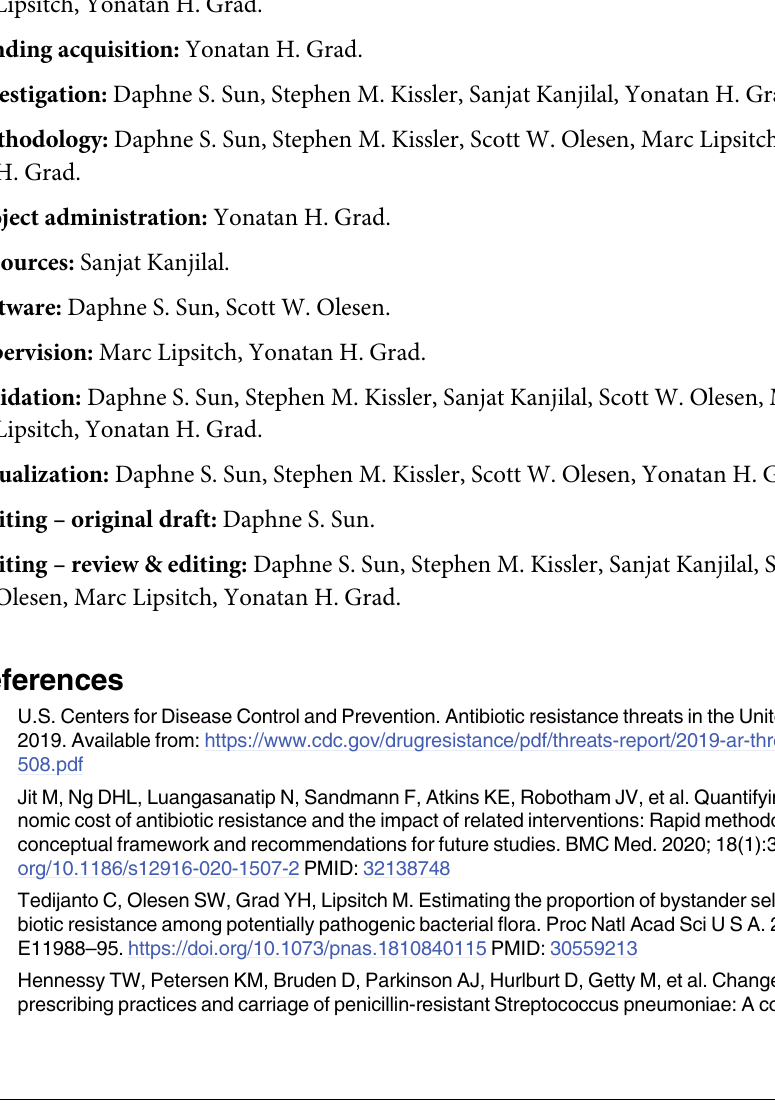
S7 Table. Comparison of the AIC values between 6- and 12-month period models for anti- biotic resistance. In parentheses is the difference in AIC from the model with the lower AIC. AIC, Akaike information